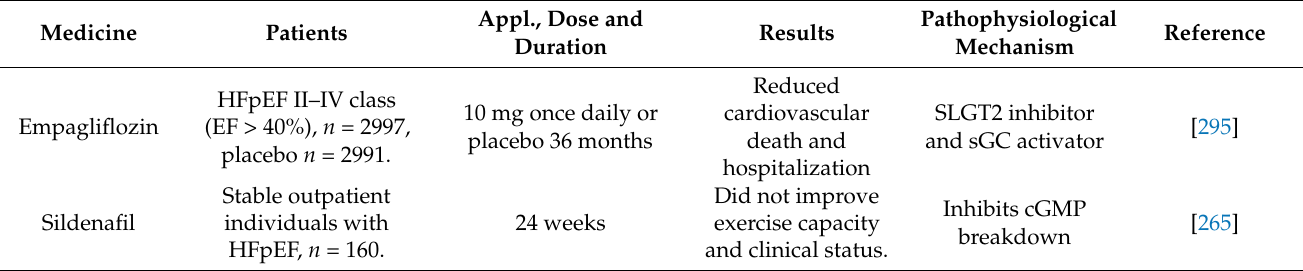
Table 4. Medicines affecting human cardiomyocytes by increasing cGMP-PKG signaling in HF patients. (LV-left ventricle, LA-left